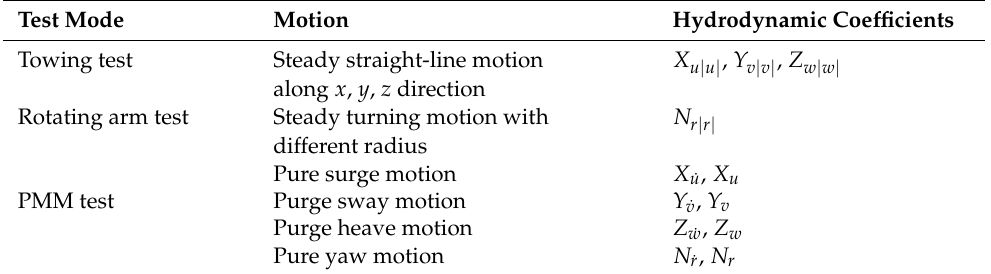
Table 3. Hydrodynamic coefficients corresponding to different test modes and motions of the underwater